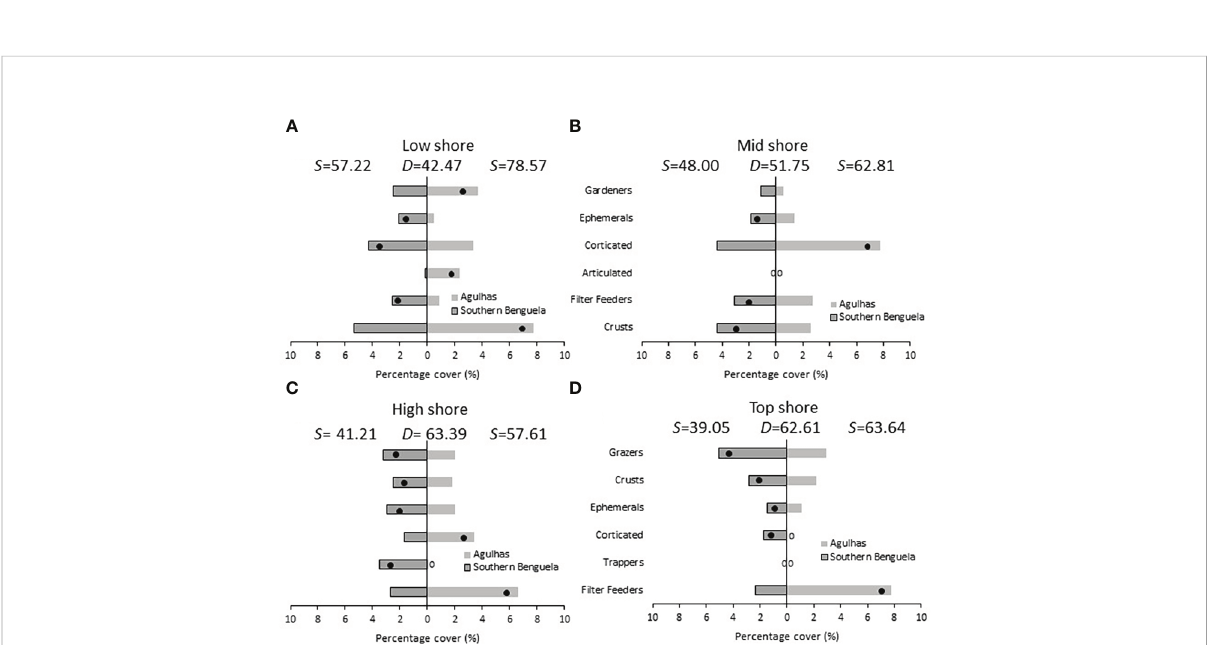
FIGURE 10 Percentage cover of groups responsible for the similarities ( S ) within ecoregions and the dissimilarities ( D ) between ecoregions at the four intertidal zones: Low shore, mid shore, high shore and top shore (A – D) . Black dots identify groups distinguishing between ecoregions, and are placed in the ecoregion with the greatest abundance; 0 =